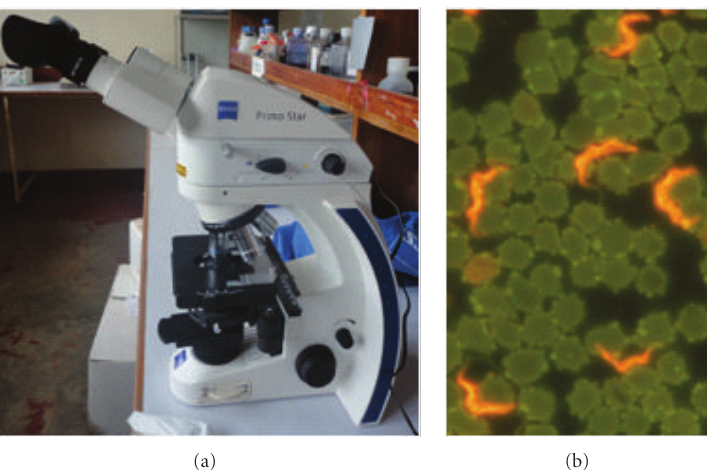
Figure 1: (a) the Primo Star iLED microscope has a UV light source that is beamed onto the slide from above, in addition to the classical white light from below, with a knob for interchange between UV and white light. (b) in presence of UV light, acridine orange stained trypanosomes fluoresce against a dark background, making it easy to detect the parasites.